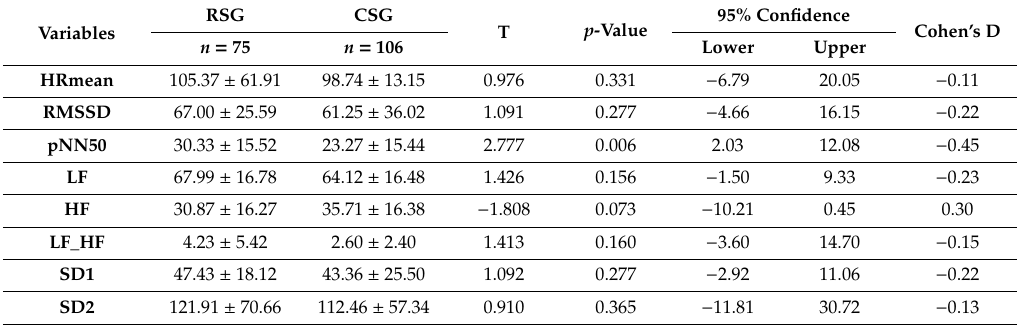
Table 1. Heart rate variability results of rural and city school students.